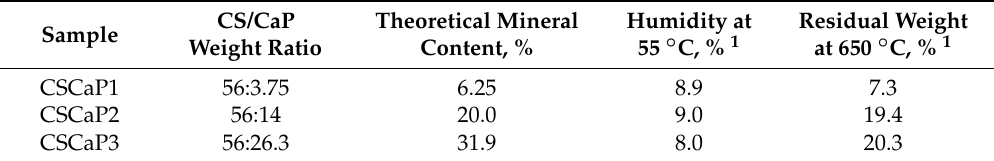
Table 1. Sample preparation conditions of CSCaP composites and thermogravimetric